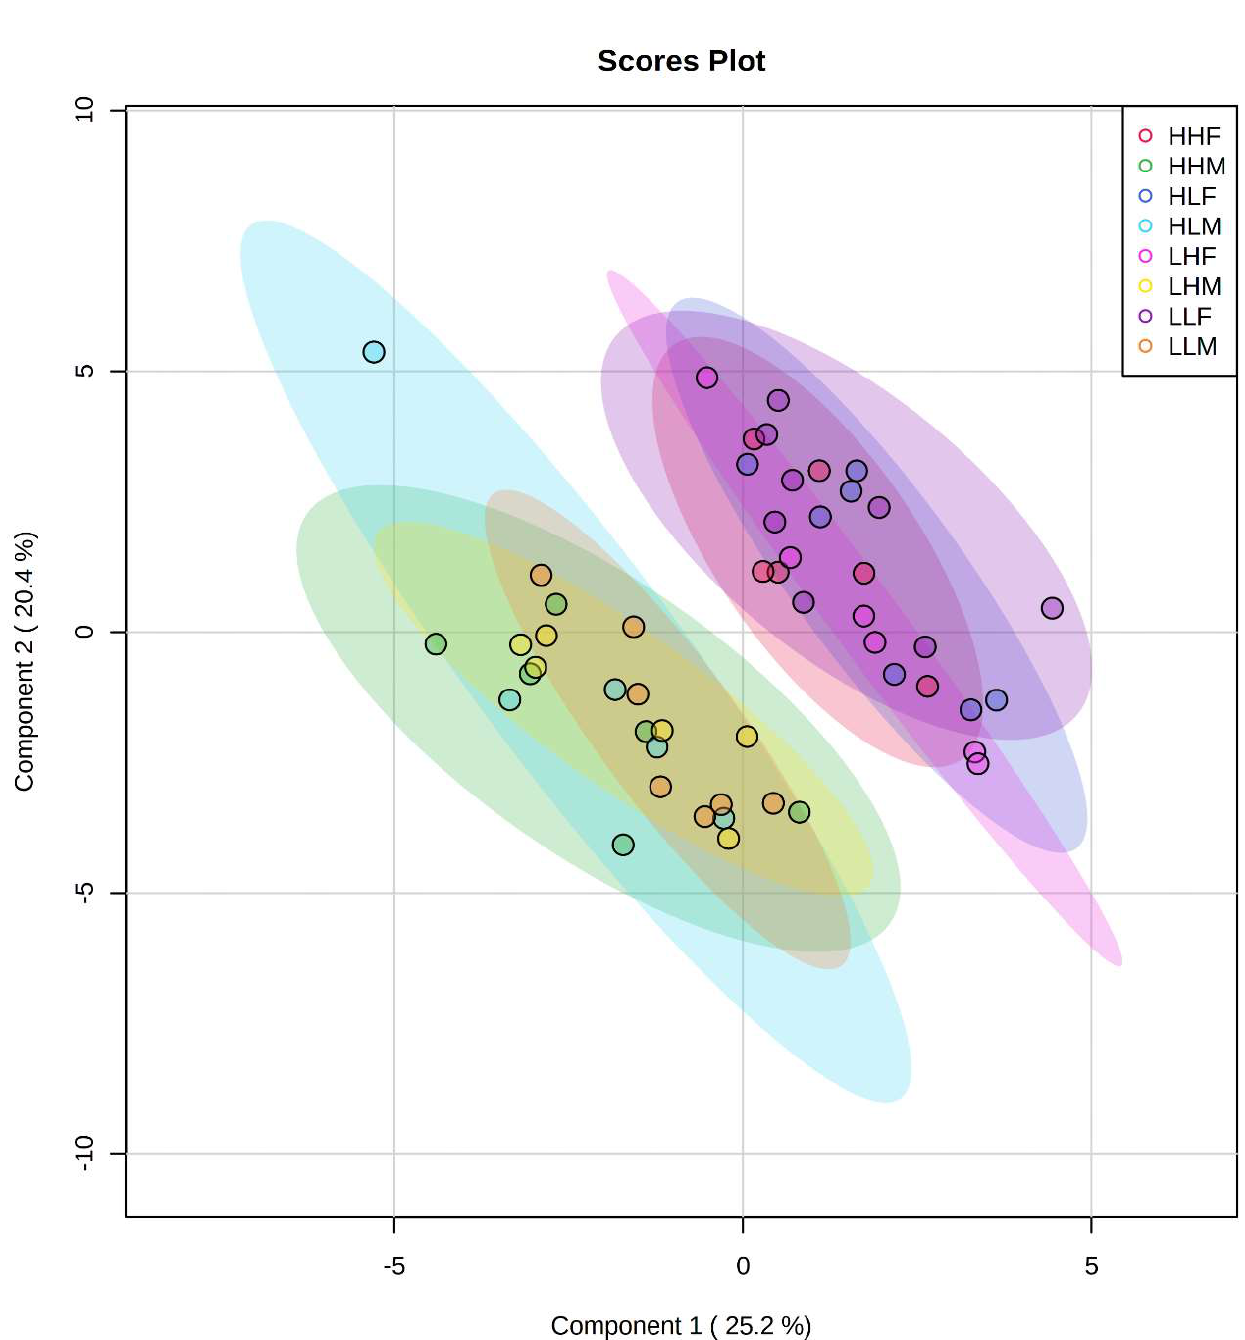
Figure 5. sPLS-DA analysis of all groups. HHF (red), HHM (green), HLF (blue), HLM (light blue), LHF (pink), LHM (yellow), LLF (purple), LLM (orange). Number of variables per component limited to 10 across all, only first 2 components (% variance) illustrated. All metabolites are logarithmically transformed. Indicated the discriminate clustering of male and female